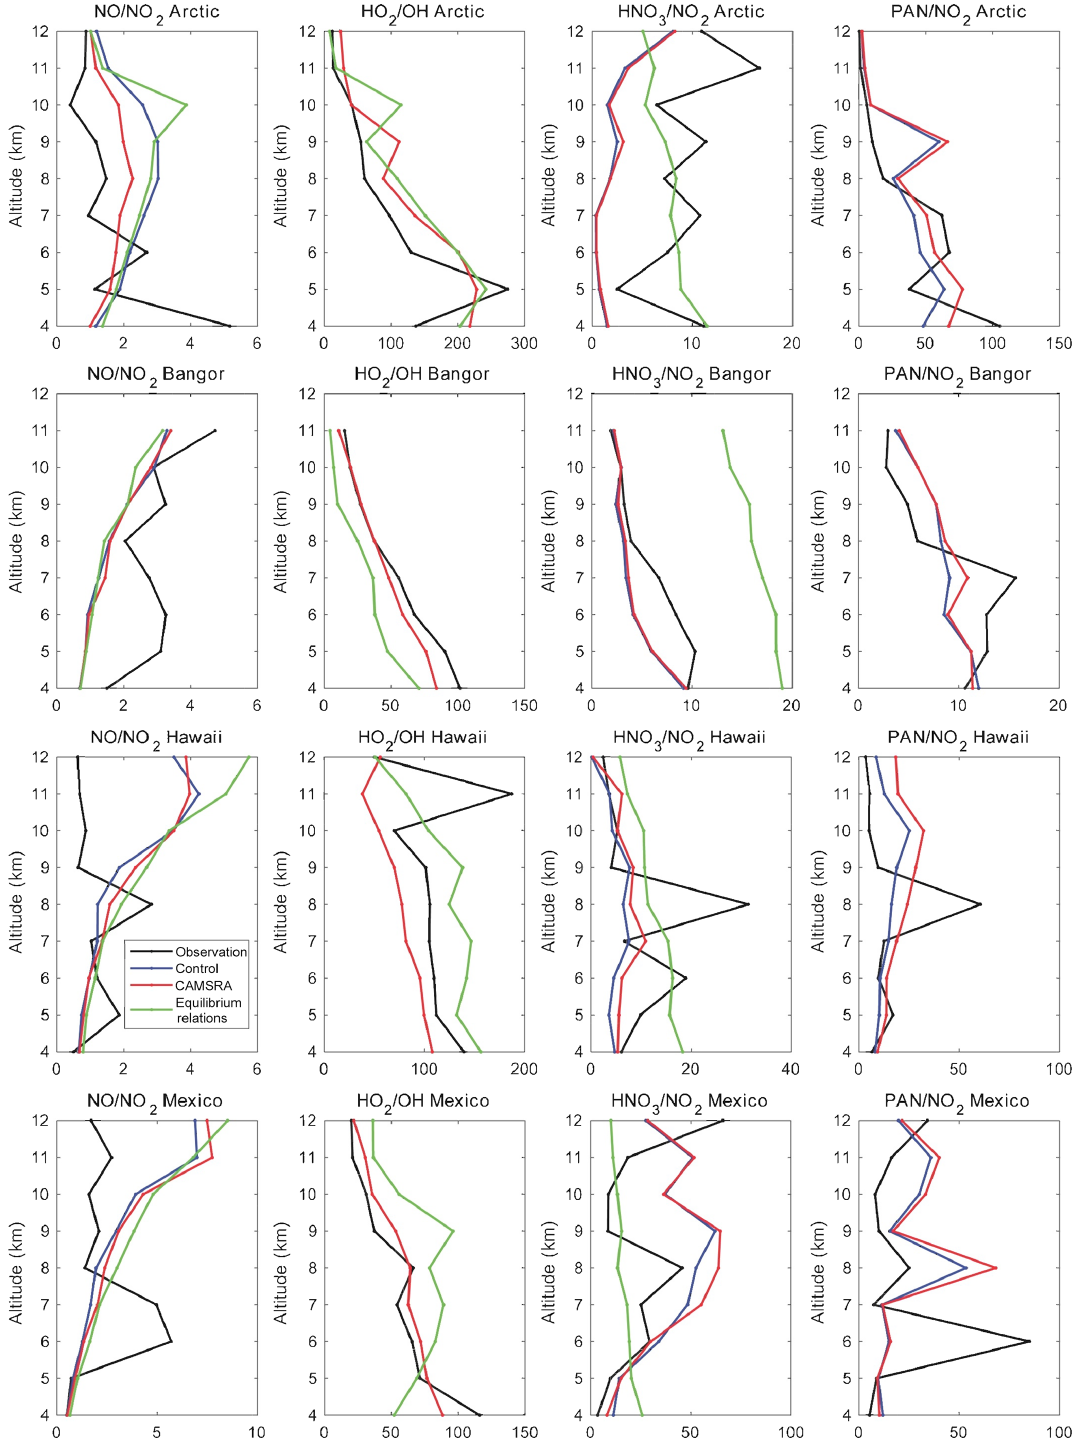
Figure 13. Concentration ratios of NO / NO 2 , HO 2 / OH, HNO 3 / NO 2 and PAN / NO 2 derived from aircraft measurements (black curves), control runs (blue curves), reanalysis (red curves) and simple equilibrium relations (except in the case of the PAN / NO 2 ratio; green curves). The values are shown in the Arctic, Bangor, Hawaii and Mexico. Note that, in most cases, the blue and red curves cannot be